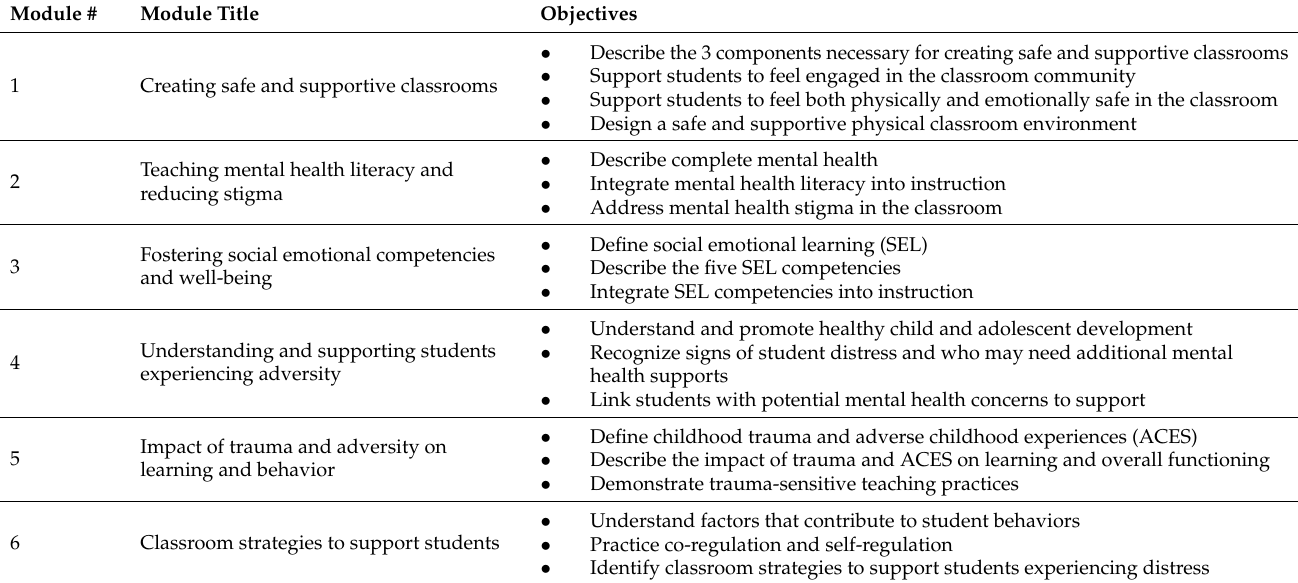
Table 4 includes the specific learning objectives for each module. Table 4. Classroom Well-Being Information and Strategies for Educators (WISE) module titles and